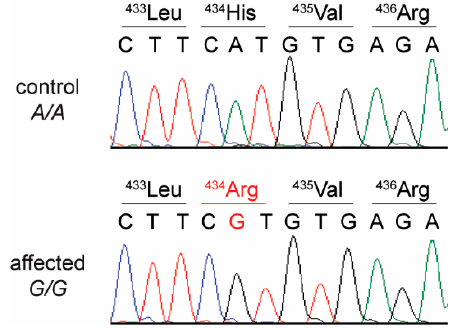
Figure 2. Details of the L2HGDH :c.c.1301A>G variant. Representative electropherograms of a control and the affected cat are shown. The amino acid translations of the wild type and mutant alleles are indicated.